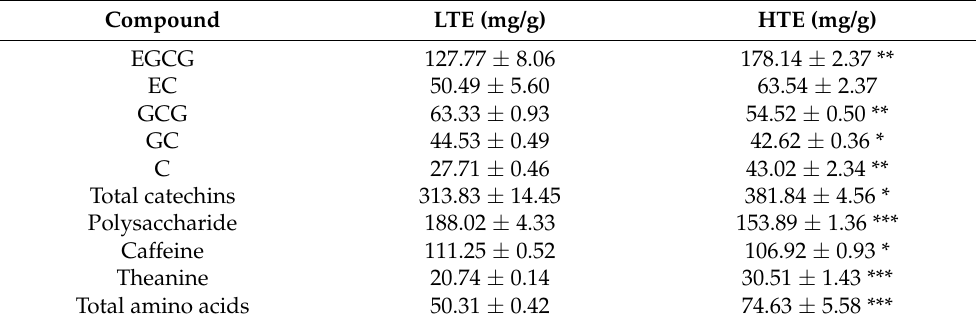
Table 1. Contents of catechins, polysaccharide, caffeine, and amino acid in lyophilized powder of tea water